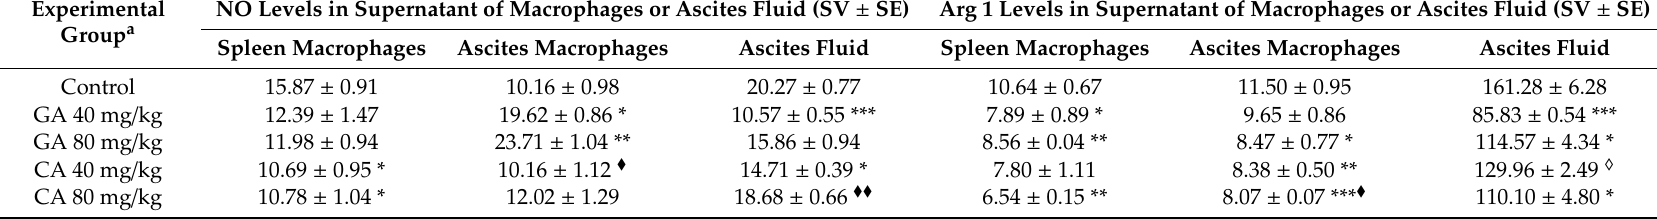
Table 3. E ff ect of GA and CA on the nitric oxide (NO) and arginase 1 (Arg1) activity in the supernatant of the spleen, ascites macrophages, and ascites fluid of mice bearing